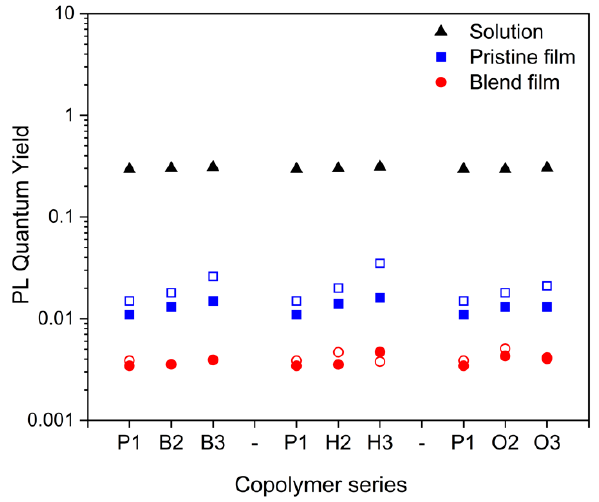
Figure 6. PLQYs of various blend films. Open symbols for before annealing and closed symbols for after annealing.